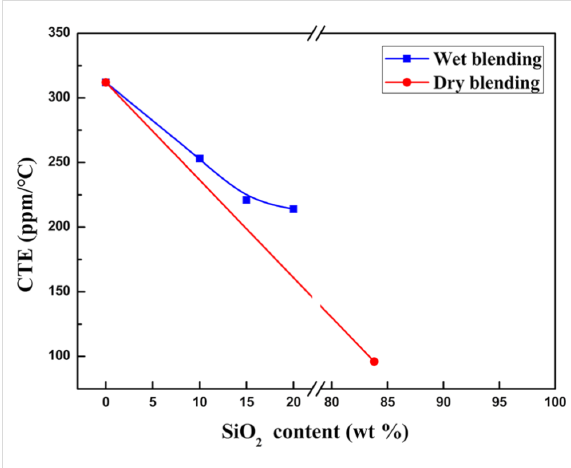
Figure 5: CTE values as a function of the content of SiO 2 nanoparti- cles.